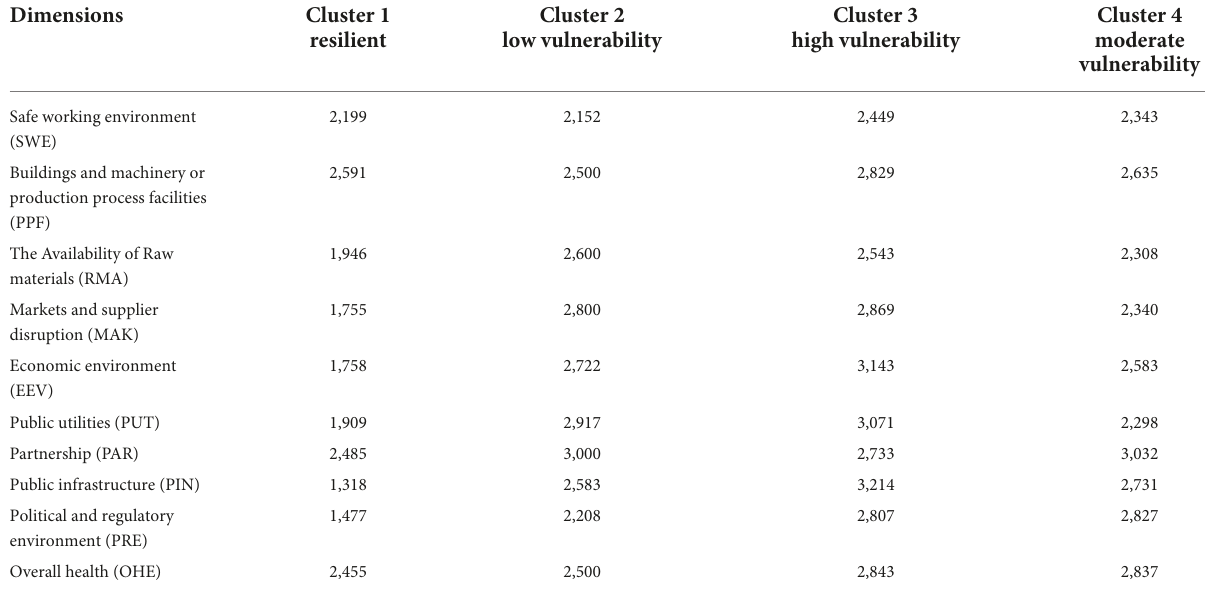
TABLE 4 The average value of the dimensions for each